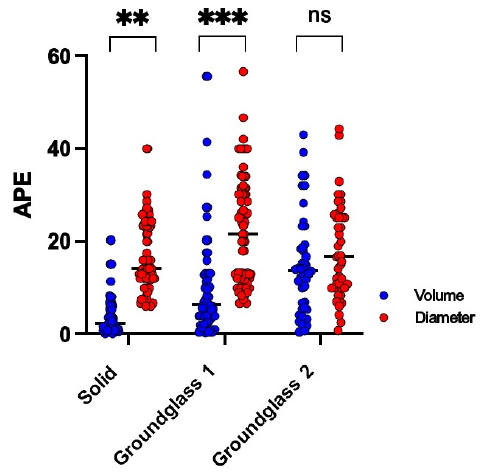
Figure 5. Absolute percentage errors (APEs) of quantified nodule volume and diameter. Nodules were separated and categorized according to density as solid, ground-glass 1 or ground-glass 2. The asterisk signifies the level of significance in APE difference between volume (blue) and diameter (red) measurements (**: p < 0.001; ***: p < 0.0001), whereas no significant difference ( p > 0.05) is labeled as “ns”. Every dot represents the APE of a single measurement in its respective